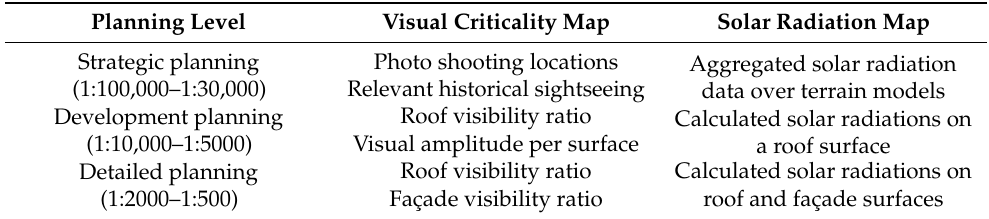
(ii) “ façade visibility ratio ”, respectively equal to the relationship between visible roof/façade areas and total roof/façade areas [62]. The combination of these maps and the potential energy consumption permits an understanding of the energy matching between production and consumption in historical areas